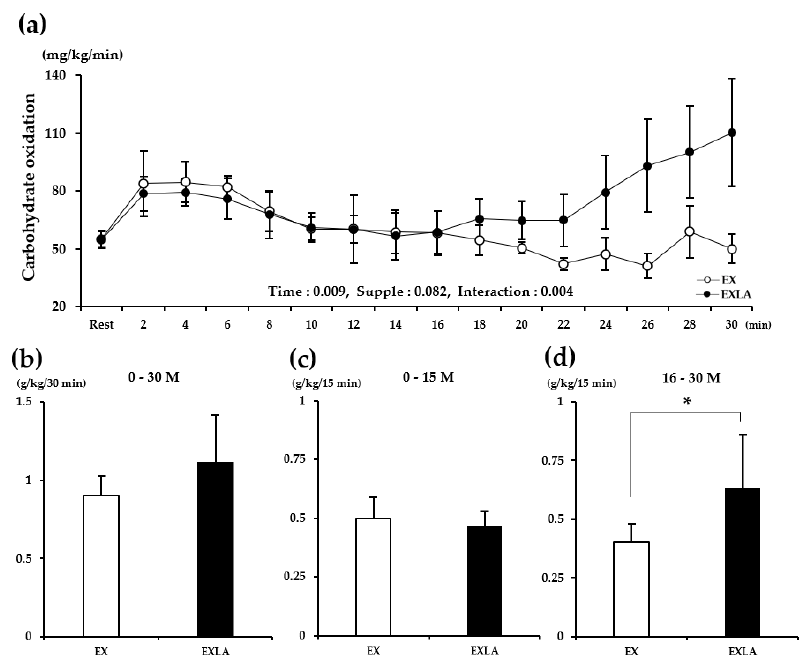
Figure 4. Changes in CO during exercise: ( a ) CO changes over time for 30 min; ( b ) total CO for 30 min; ( c , d ) total CO for 0–15 min (0–15 M) and 16–30 min (16–30 M), respectively. Supple, supplement effect; Inter, interaction effect; CO, carbohydrate oxidation; EX, exercise control group; EXLA, exercise with lactate intake group. Values represent the mean ± standard deviation ( n = 8). * p < 0.05.